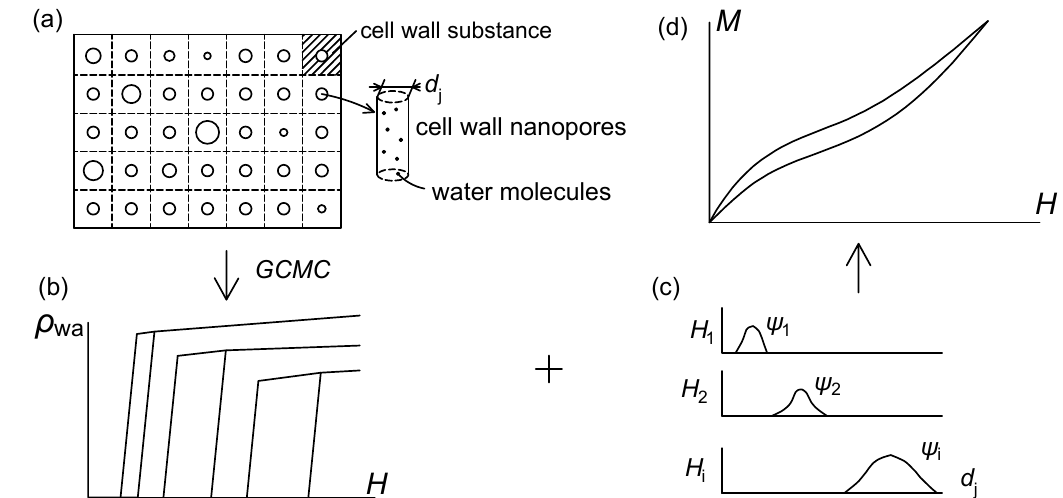
Figure 1. Illustration of the wood cell wall nanopore model and modelled sorption isotherms. ( a ) the cell wall substance and nanopores with an initial pore size distribution ψ 1 ; ( b ) simulated sorption isotherms for different pore sizes d j ; ρ wa represents the adsorbed water density ( c ) cell wall pore size distributions ψ i evolving with humidity; ( d ) the eventual wood water sorption isotherm simulated.